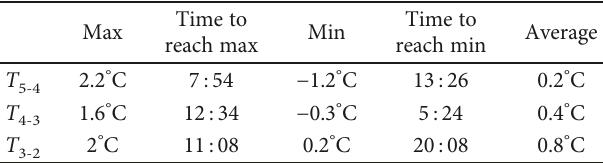
Figure 6: Temperature di ff erence between the nodes of the exterior air channel. Table 2: Summarized result of temperature di ff erence between nodes of the exterior air channel.